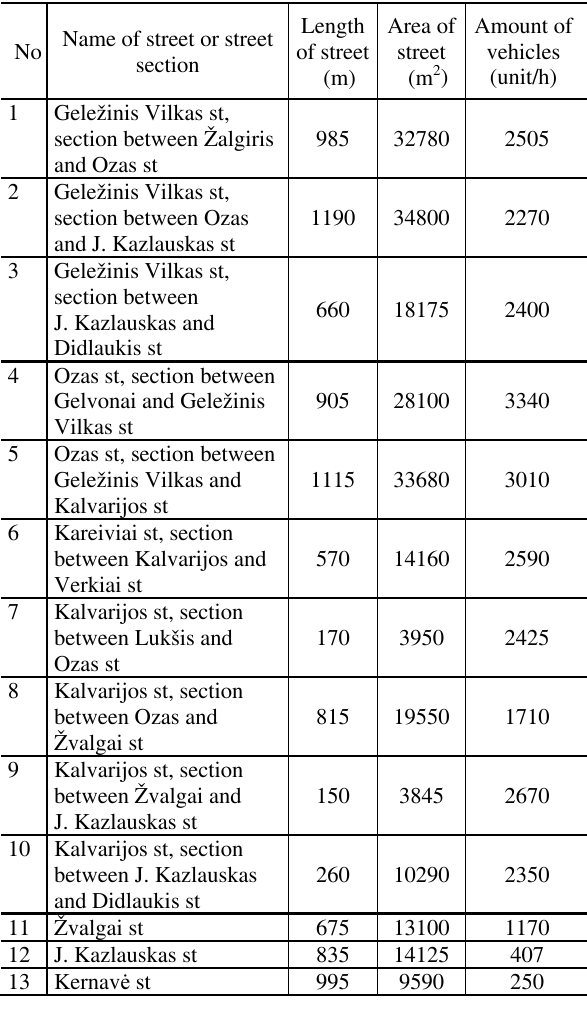
Table 2 . Motor transport flows in studied area during